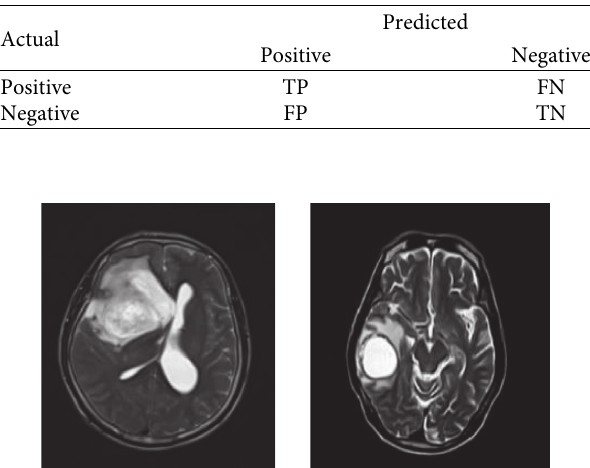
Figure 3: Image of the T2 pulse sequence showing the patient’s brain